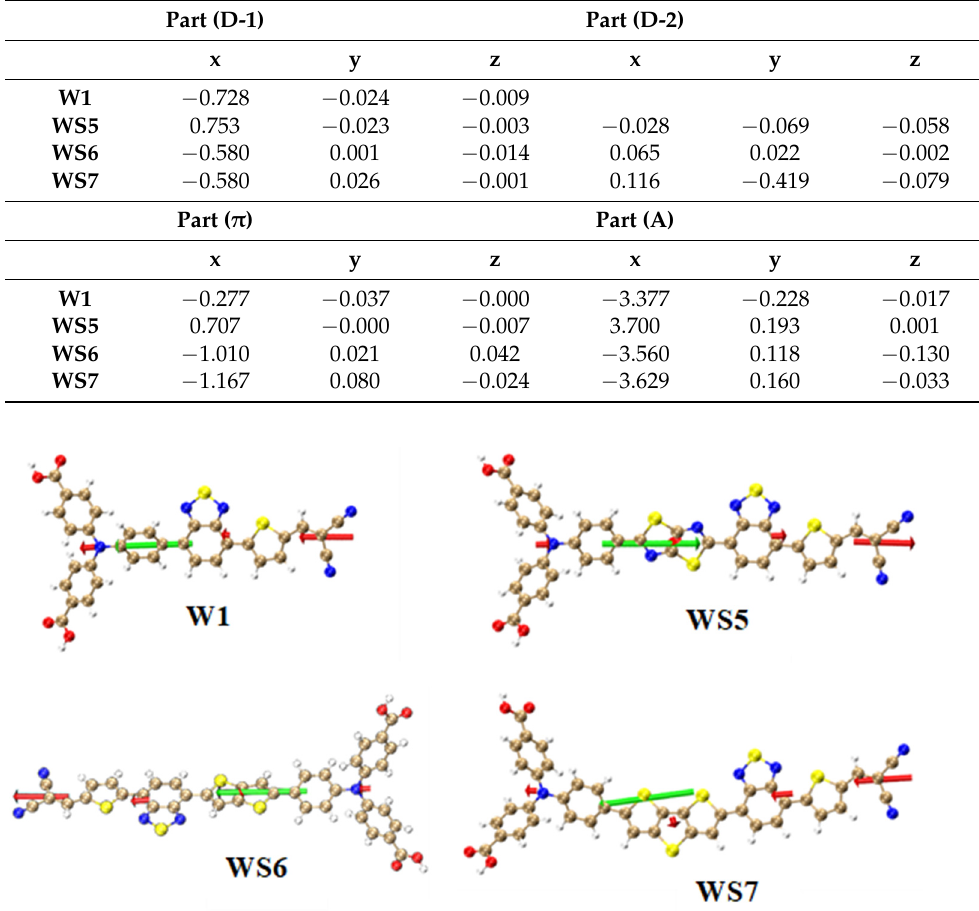
Figure 7. Transitional dipole moments of W1, WS5, WS6, and WS7. The red arrows represent the contribution of the fragments to the transition dipole moment, and the green arrows represent the total transition dipole moment of the molecule.